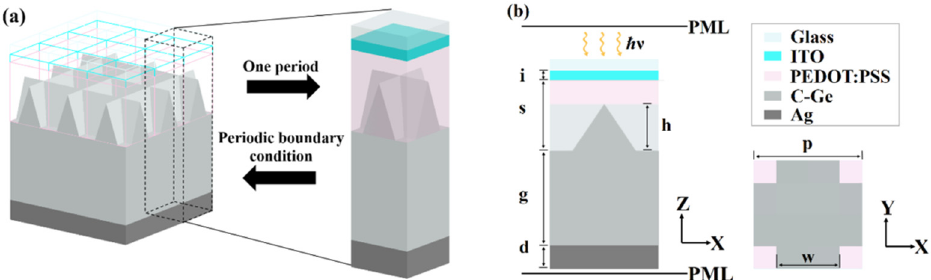
Figure 1. ( a ) Germanium ‐ based solar cell device under periodic arrangement. ( b ) 2D view and material composition of each layer. i is the thickness of the ITO layer, s is the thickness of PEDOT:PSS, g is the thickness of the substrate germanium, d is the thickness of the bottom silver electrode, h is the height of the germanium cross cone nanostructure, p is the width of the germanium nanostructure array in one period and w is the bottom width of the germanium cross cone nanostructure.